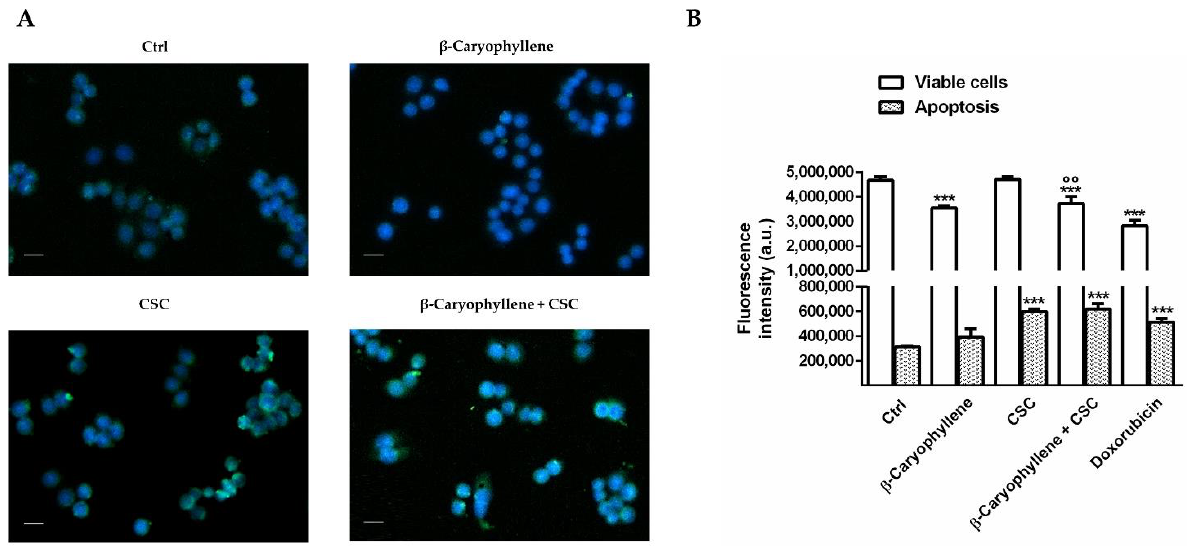
Figure 11. Apoptosis rate induced by β -caryophyllene, cigarette smoke condensate (CSC) and the positive control doxorubicin in MDA-MB-468 cancer cells after 24 h exposure. ( A ) Representative images of cells stained by Annexin V and Hoechst 33,258 dye. ( B ) Data are displayed as mean ± SE of at least three independent experiments with at least three technical replicates ( n = 9). *** p < 0.001, significant lowering of cell viability with respect to the control (ANOVA + Dunnett’s multiple comparison post-hoc test). ◦◦ p < 0.01, significant difference with respect to CSC (Student’s t -test). Scale bars = 20 μm.